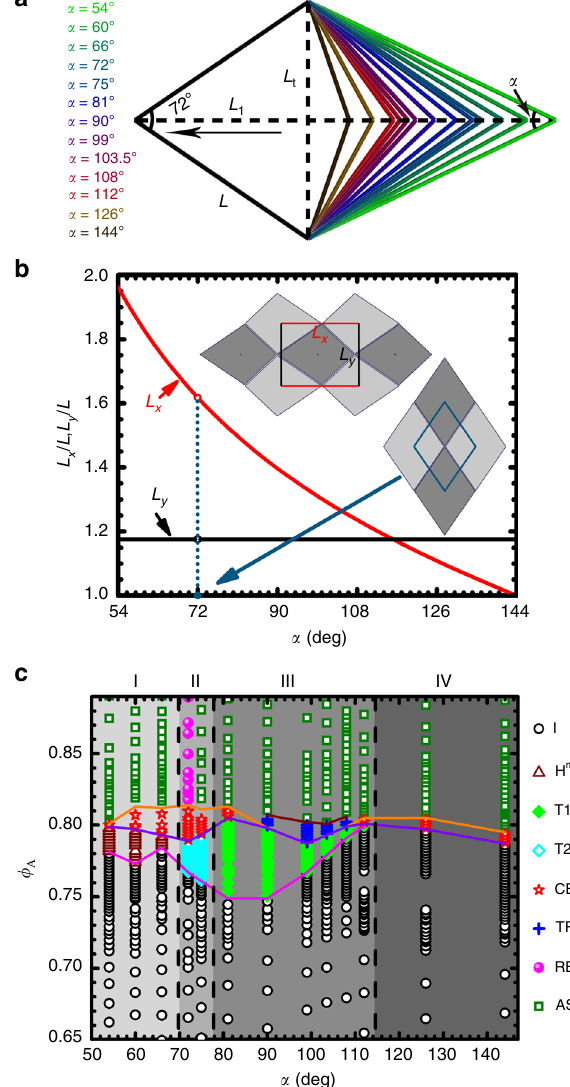
Fig. 1 Sketch of kites and their phase diagrams obtained by MC simulations. a Sketch of kites with a fi xed vertex angle of 72° and associated edge length of L , and a tunable shape parameter of angle α from 54° to 144°, whose vertex is opposite to the fi xed 72° vertex. L l is the length of particle diagonal connecting the vertices of 72° and α , L t is the length of particle diagonal perpendicular to L l . L l / L t is de fi ned as the aspect ratio of particle. Black arrow in particle indicates the pointing direction from α vertex to the fi xed 72° vertex, which is de fi ned as the orientation of particle. b The length of two lattice vectors L x and L y of a unit cell when kites are in the closest packed ASX phase at different α . c Phase diagram of kites obtained from MC simulations using NPT and NVT ensembles. I: isotropic, H mo : hexatic phase in molecular-orientational order, T: tetratic, CE: coexistence, TRX: tetragonal rectangular crystal, RB: rhombic crystal, ASX: alternating striped crystal. Solid lines indicate the determined phase boundaries: dark purple line: phase boundaries between ASX and TRX; orange line: melting transition from crystal phase (ASX/RB or TRX) to liquid crystal phases or isotropic liquid phases; purple line: freezing transition from liquid crystal phases or isotropic liquid phases to crystal phases; magenta line indicates the phase boundaries between isotropic liquid phases and liquid crystal phases (tetratic or